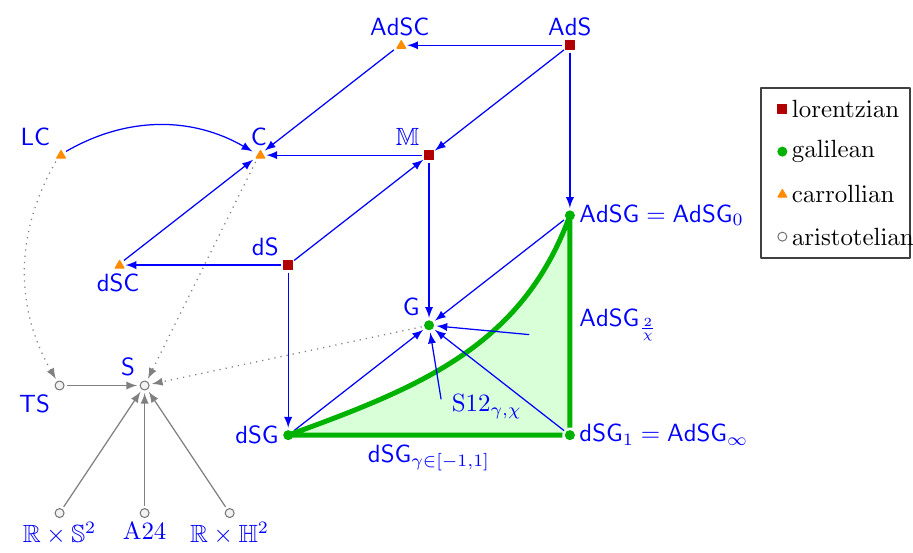
Figure 4 . Three-dimensional homogeneous spacetimes and their